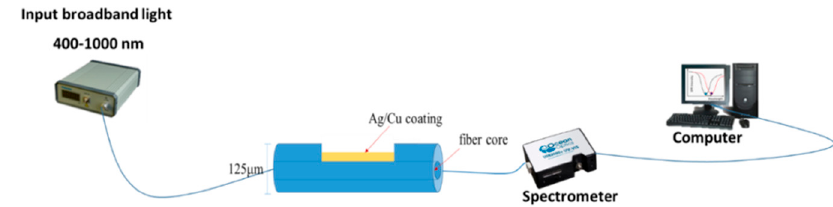
Figure 5. Schematic diagram of the D-shaped sensor covered with Ag, Cu and Ag/Cu.